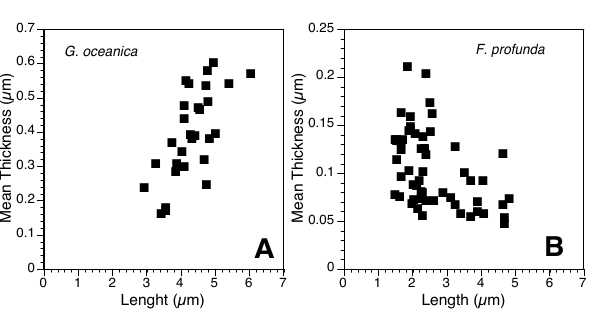
Figure 4 Fig. 4. Scatter plots of length versus thickness for G. oceanica (A) and F. profunda (B) indicating that the thickness of F. profunda does not increase with increasing length as it does in most other